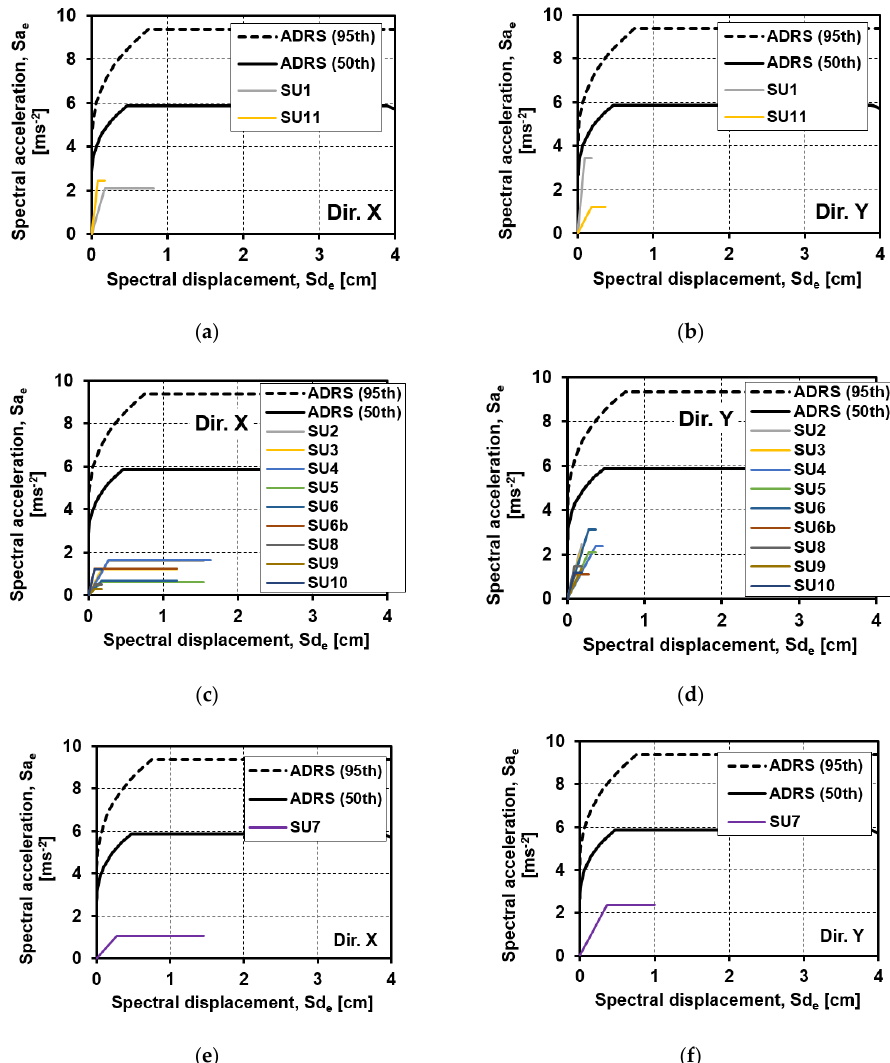
Figure 14. Capacity curves of SUs in the ADRS plane; ( a ) Corner SUs, X dir.; ( b ) Corner SUs, Y dir.; ( c ) Intermediate SUs, X dir.; ( d ) Intermediate SUs, Y dir.; ( e ) Head SU, X dir.; ( f ) Head SU, Y dir.